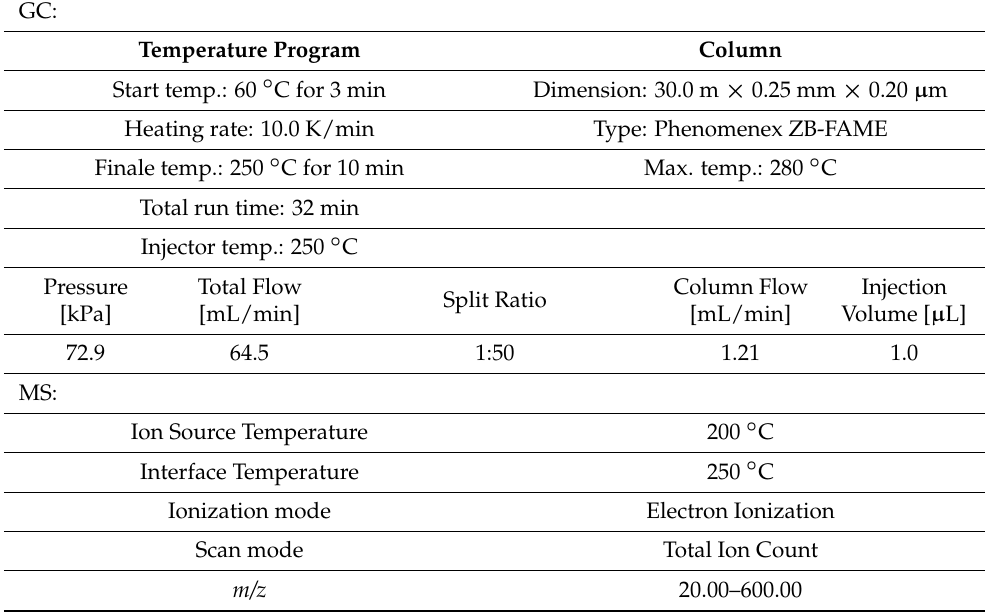
Table 2. GC-MS operating parameter for the determination of epoxides and ketones.